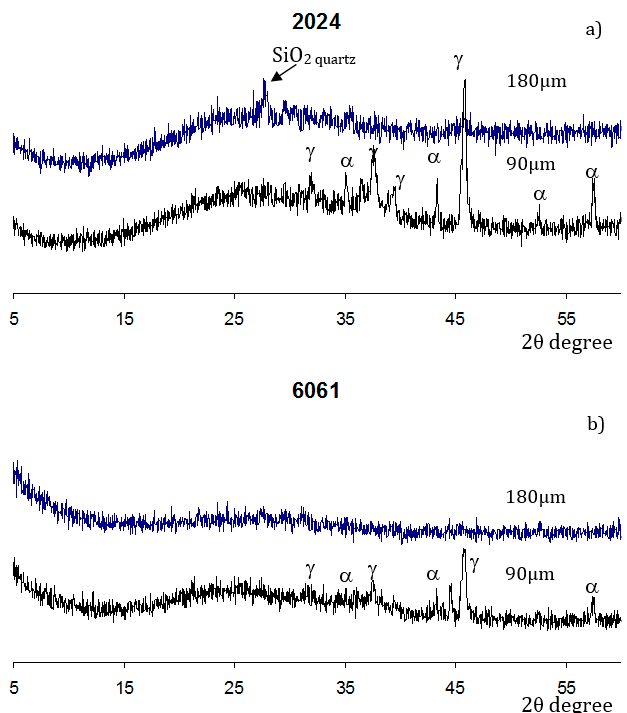
Figure 4. XRD patterns of PEO coatings on ( a ) the Al 2024 and ( b ) Al 6061 alloys, with two residual thicknesses (90 and 180 µm). α — α -Al 2 O 3 ; γ — γ -Al 2 O 3 .